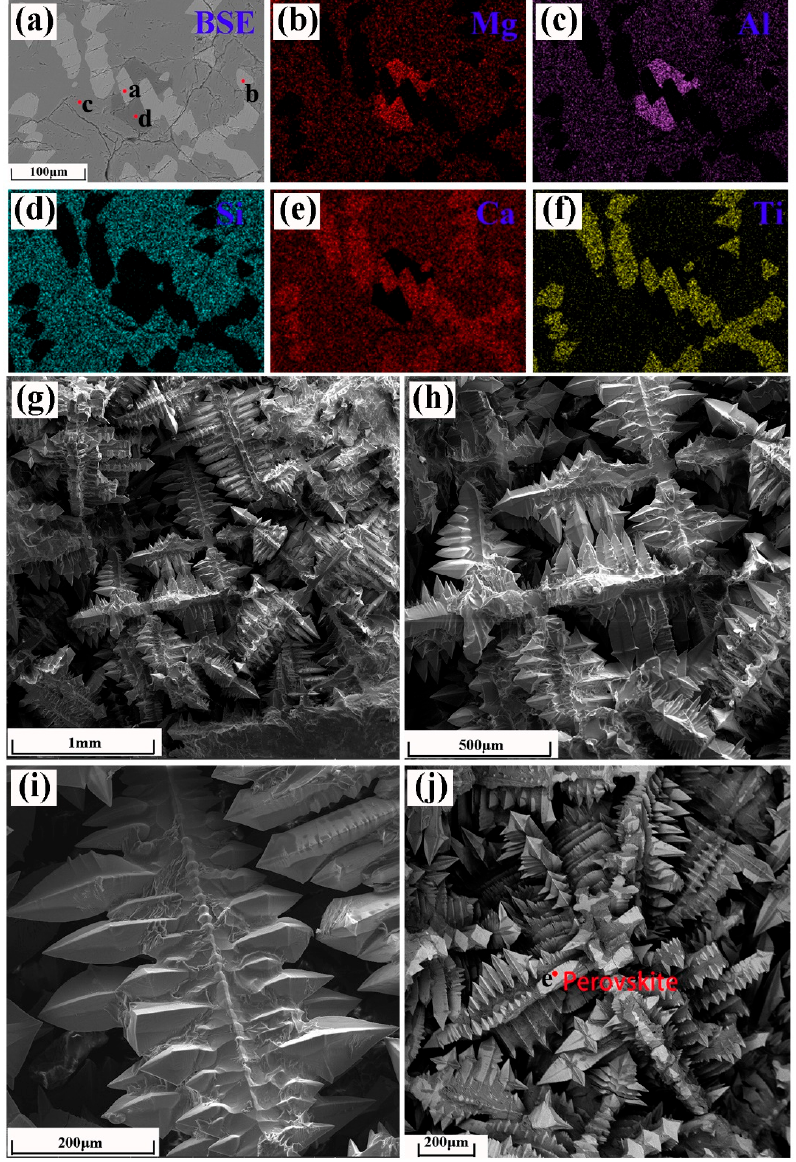
Figure 4. ( a ) Backscattered electron image (BSE) image, and ( b – f ) mapping of the elements corre- sponding to ( a ); ( g – j ): 3D morphologies of cooled slag with basicity of 1.3. Table 3. EDS composition distribution corresponding to Figure 4a (a–d points) and Figure 4j (e point) (atom.%).